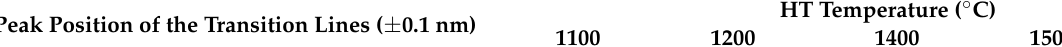
Peak Position of the Transition Lines ( ± 0.1 nm)